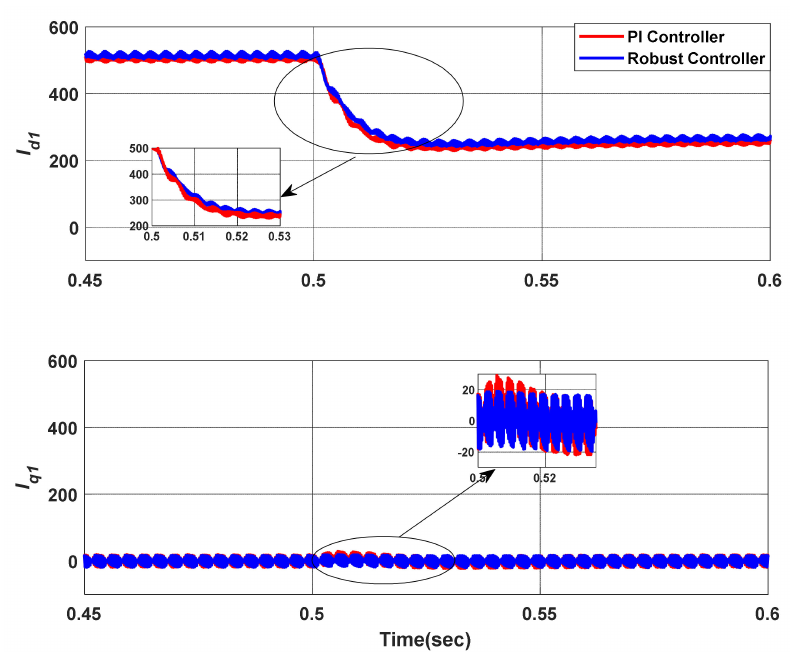
Figure 13. I d1 and I q1 for the nominal case for a 50% step change in active